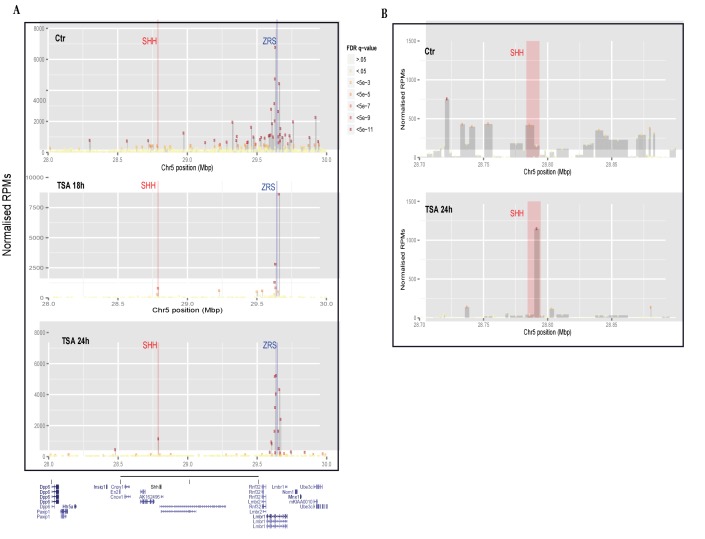
Trichostatin A (TSA) treatment induces a ZRS–SHH interaction.(A) The profile of 4C-seq at the ZRS locus in 14Fp cells. Control and TSA treatment after 18 and 24 hr are shown. ZRS shown as the enhancer (anchor) bait fragment along an approximately 2 Mb region of chromosome 5 (UCSC genome browser view of chr5:28,000,000–30,000,000 (mm9)). The x axis represents the position on chromosome 5 and the y axis the normalized reads as read per million sequences (RPMs). Only highly signiﬁcant interactions are shown (false discovery rate [FDR] q-value <5⇥105). The blue bar represents the location of the ZRS (bait) and the red bar represents the Shh gene. Each rectangle is a restriction fragment, the dots coloured at the top of each rectangle reflect the FDR q-value indicating the signiﬁcance of the interaction (legend between A and B). (B) Focus on the Shh region (red bar in the zoomed-in view) shows the number of interactions of the bait region with SHH in both untreated and TSA treated (after 24 hr) samples.